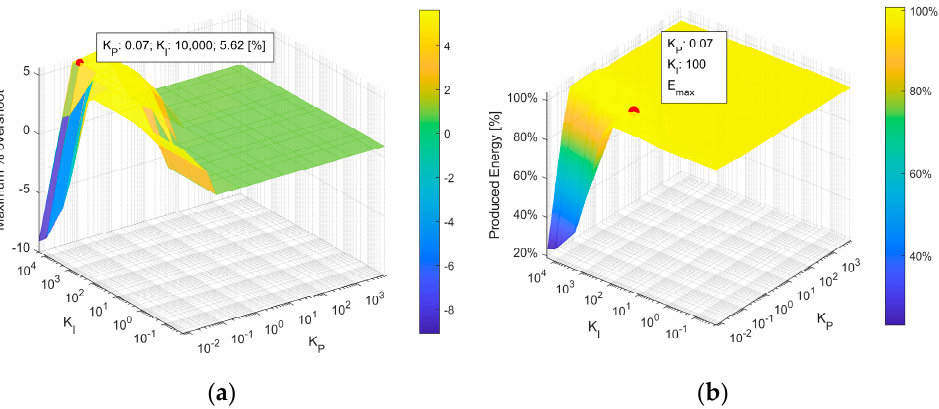
Figure 11. Results of sensitivity analysis for the PI controller parameters: ( a ) Energy production and ( b ) maximum percentage overshoot.